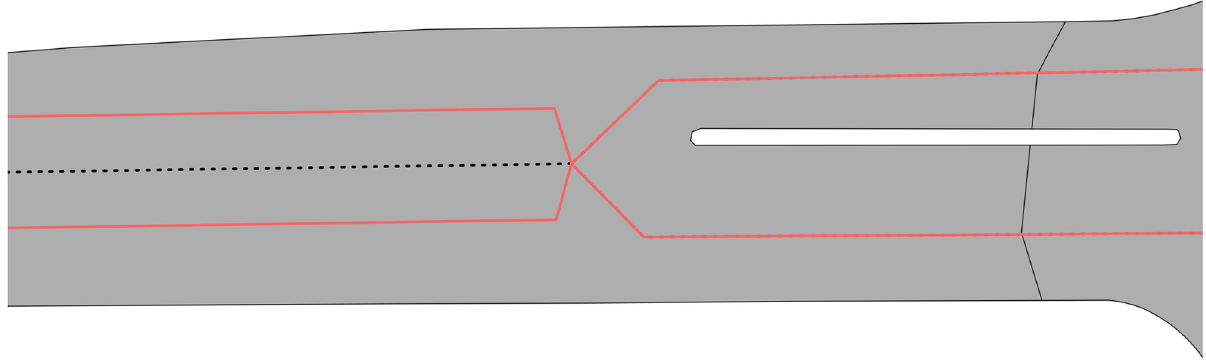
Fig 8. Mismatch between existing dual carriageways in OSM and our reconstructed dual carriageways.